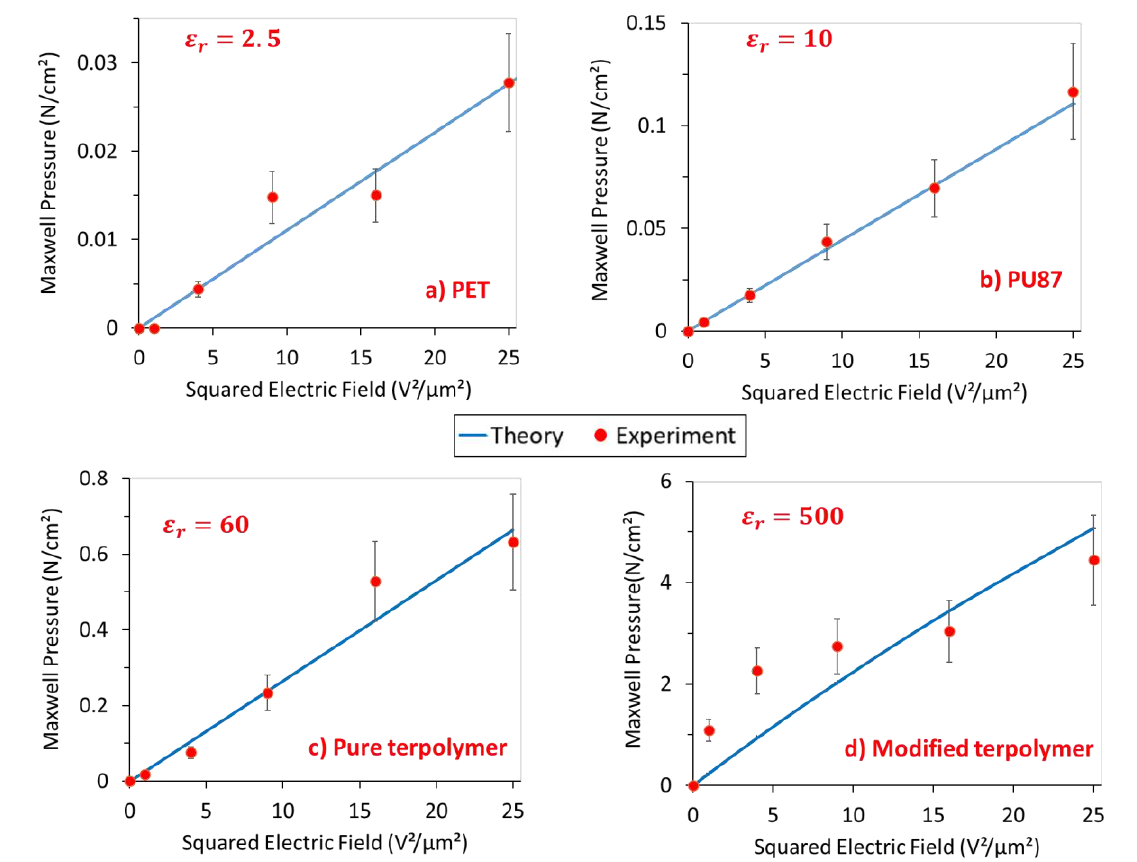
Figure 8. Experimental and theoretical data of Electroadhesion for different polymers comprising ( a ) PET; ( b ) PU87; ( c ) pure terpolymer; and ( d ) modified terpolymer.